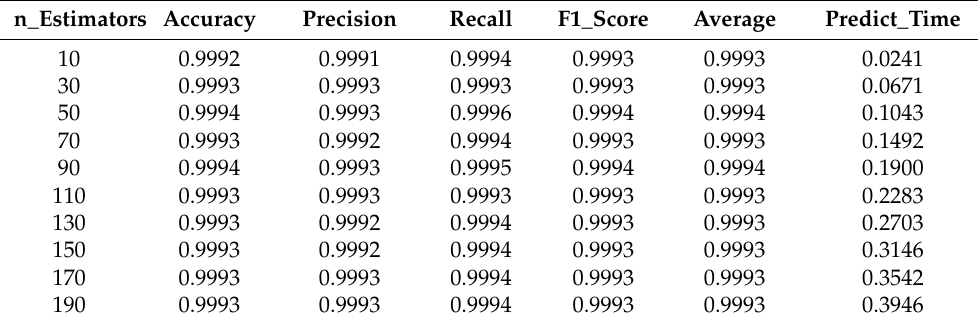
Table 9. n_estimators optimization performance table.